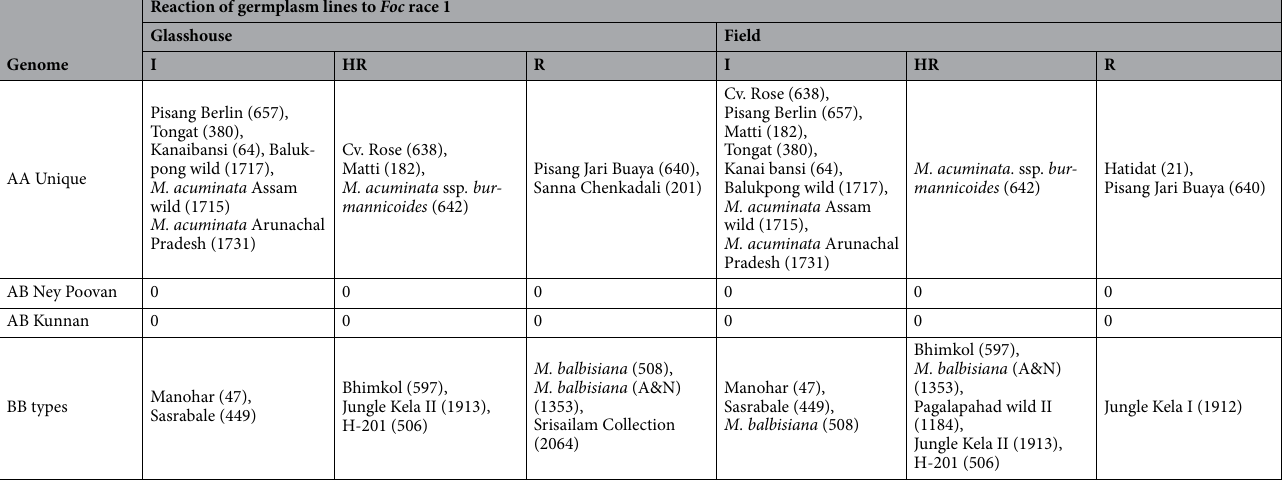
Table 2. Diploid genotypes resistant to Foc race 1 (VCG 0124) under glasshouse and field conditions. I-Immune; HR-Highly resistant;